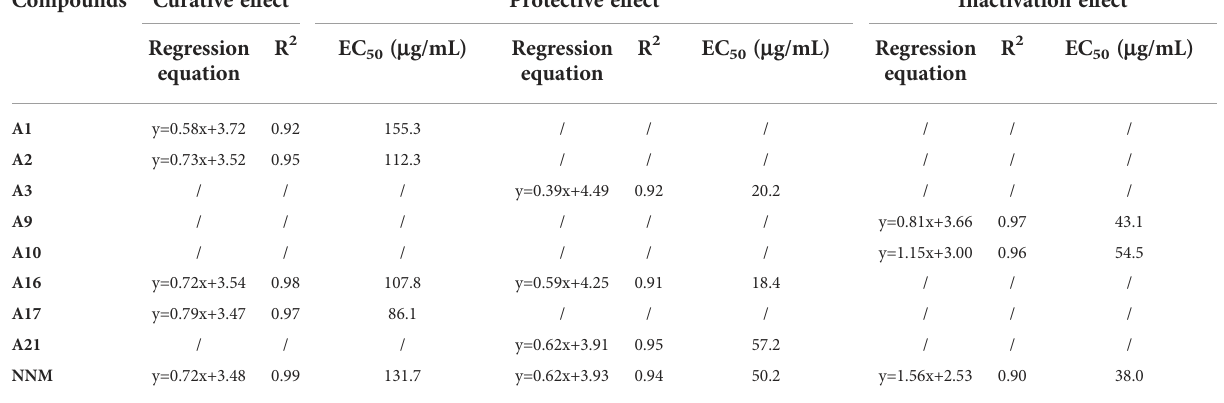
TABLE 2 EC 50 of active title compounds against TMV.